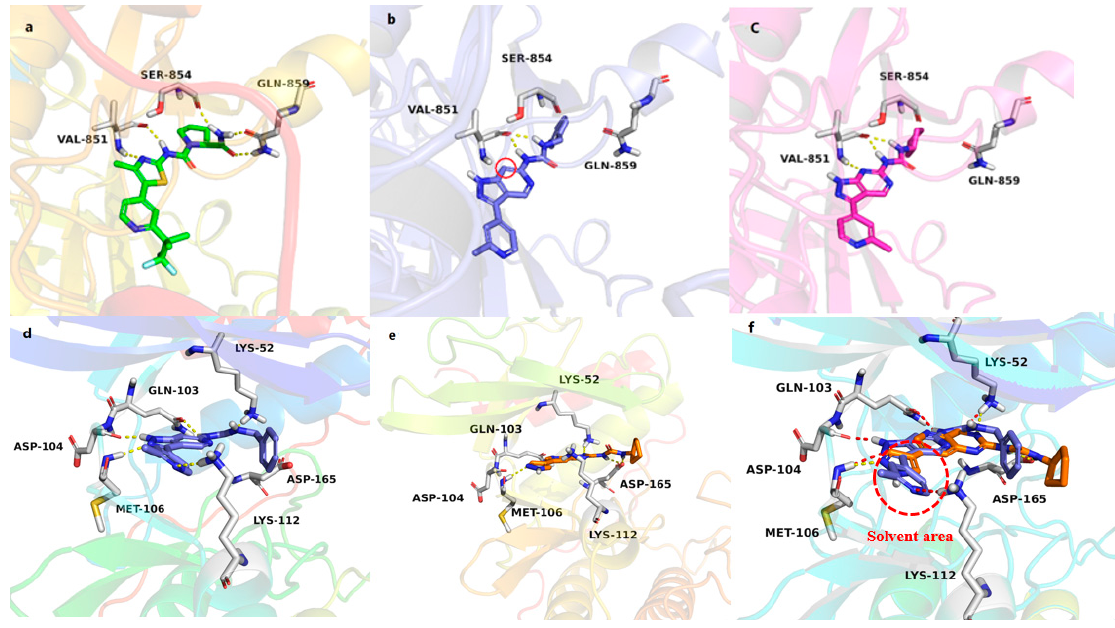
Figure 4. The 3D interactions diagram of complex structures ( a ~ c : PDB code 4JPS; d ~ f : PDB code 5KE0). ( a ) X-ray structure of Alpelisib (green) bound to PI3K α ; ( b ) ERK-A (purple) docked into X-ray structure of PI3K α . ( c ) 16b (red) docked into X-ray structure of PI3K α . ( d ) X-ray structure of ERK-A (purple) bound to ERK 2; ( e ) 32d (orange) docked into X-ray structure of ERK 2; ( f ) Overlap of the proposed binding modes of ERK-A (purple) and 32d (orange) in ERK2. The figure was generated using PyMol (http://www.pymol.org/).